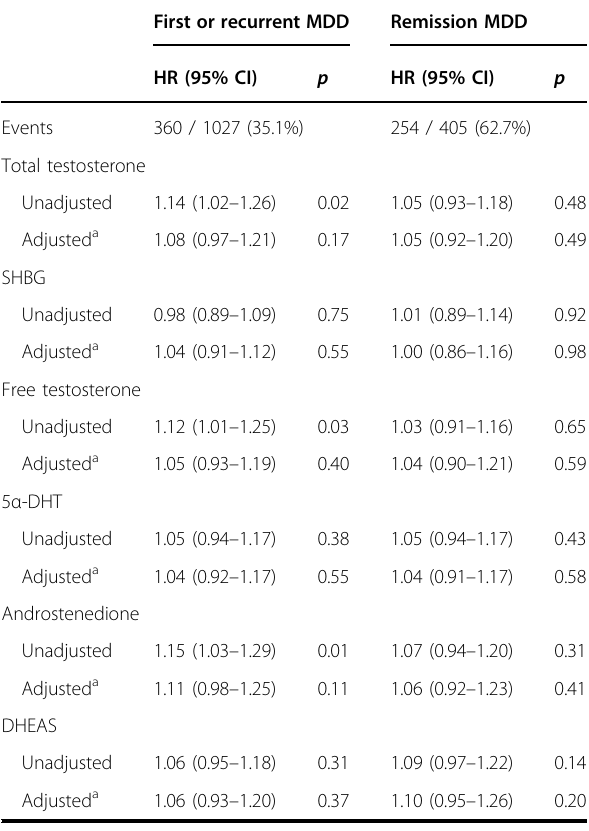
Table 2 Unadjusted and adjusted hazard ratios for time to new/recurrent episode of MDD and time to remission of MDD in women according to plasma androgen and SHBG levels during up to 4 years of